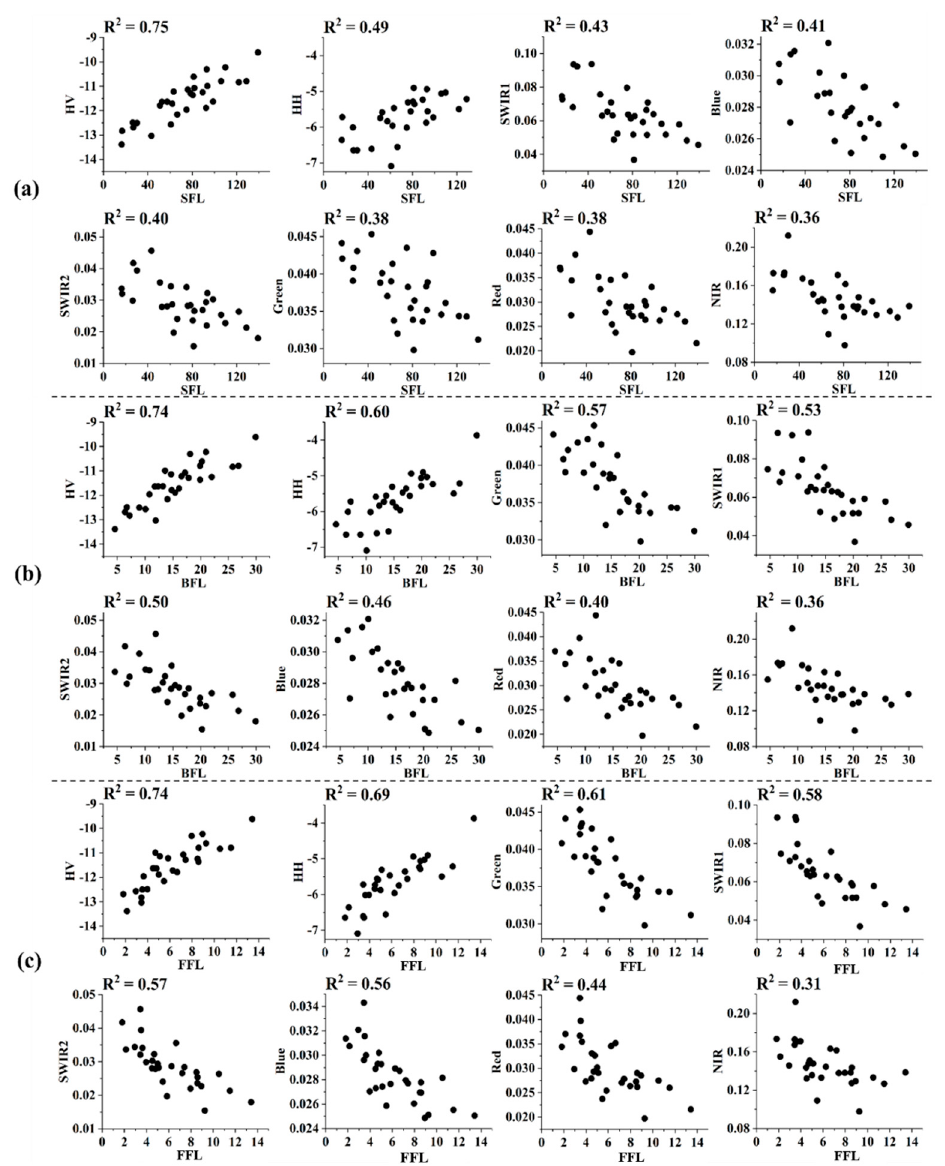
Figure 3. Scatterplots between satellite data and fuel loads. From top to bottom are SFL ( a ), BFL ( b ) and FFL ( c ), respectively. These figures were sorted by relevance from left to